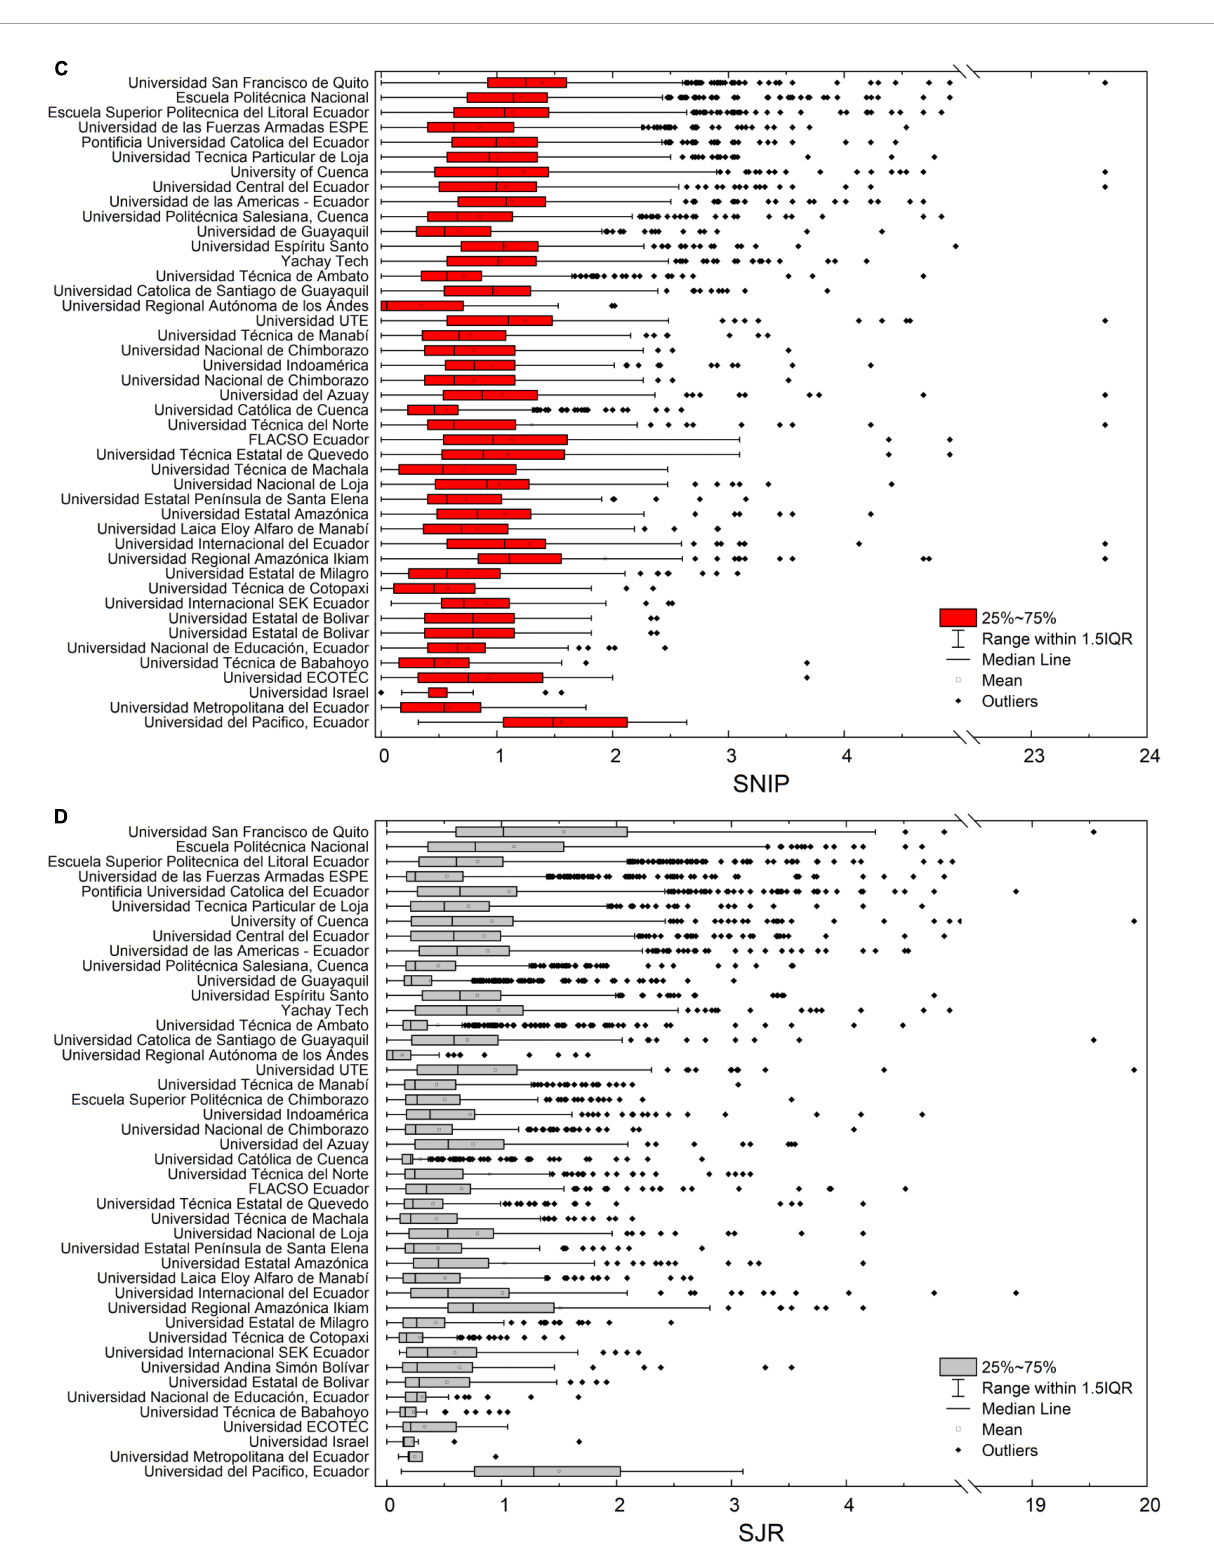
FIGURE6 Impact factor of all Ecuadorian Universities (A) , CiteScore (B) , SNIP (C) , and SJR (D) for each of the Ecuadorian Universities.